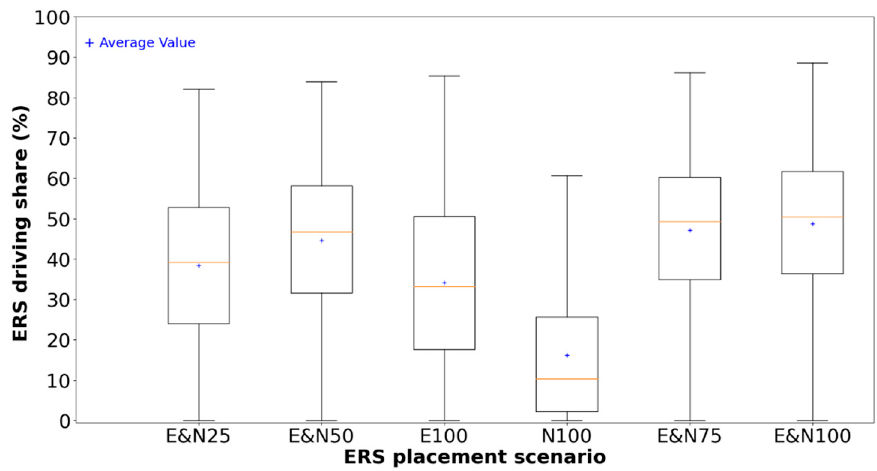
Figure 2. Box plots for the ERS driving share in six ERS scenarios. E and N25, E and N50, E and N75, and E and N100 refer to scenarios with ERS implemented on 25%, 50%, 75%, and 100% of both E and N roads, respectively, measured by traffic volume. E100 and N100 refer to European (E) and National (N) roads only, respectively. The scenarios are ordered according to road length from the shortest on the left to the longest to the right, although E and N50, E100, and N100 have roughly the same road length.